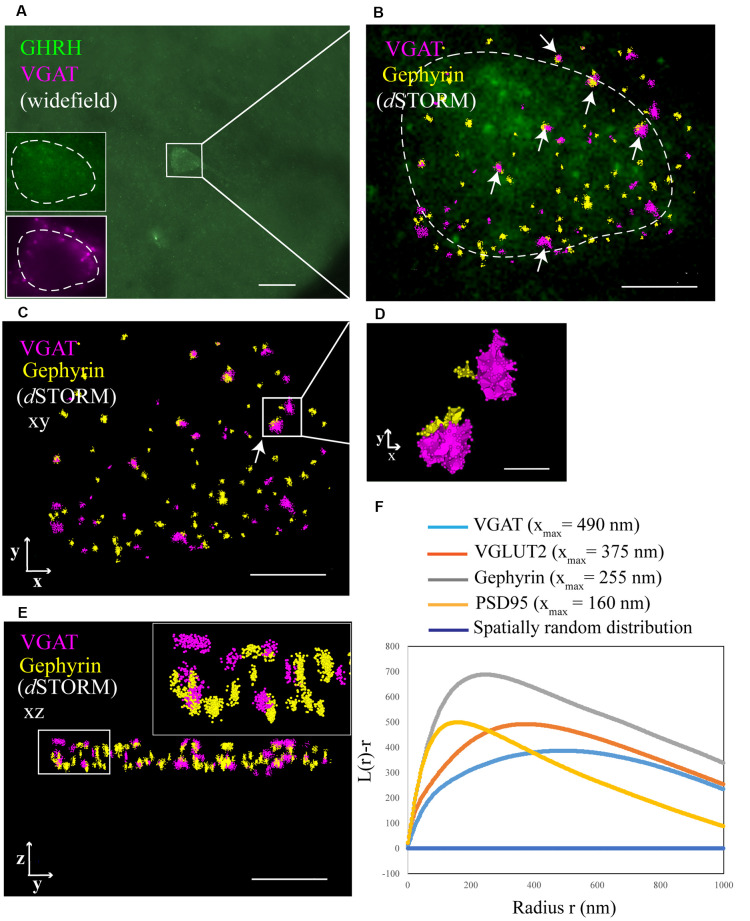
Identification of synaptic inputs to GHRH neurons with dSTORM. (A) An overview widefield image of a GHRH-positive neuron (AF488, green) in the arcuate nucleus of the hypothalamus and two widefield zoomed-in images of the same GHRH cell (left bottom corner, top insert) and of a pre-synaptic marker VGAT (AF647, magenta; bottom insert). (B) Enlarged view of the reference GHRH cell shown in panel (A), with inhibitory VGAT and Gephyrin (post-synaptic) clusters imaged using dSTORM and rendered with a Density-Based Spatial Clustering of Applications with Noise (DBSCAN) algorithm, displayed as pointcloud. Synaptic inputs to GHRH neurons are shown with arrows and identified as opposing pre- and post-synaptic clusters with an inter-cluster distance of <250 nm. (C) A pointcloud visualization of synaptic markers from panel (B) without the reference GHRH cell in the background, shown in the XY-plane. (D) Enlarged clusters of VGAT and Gephyrin from panel (C) to highlight lateral resolution. (E) YZ-plane depiction of VGAT and Gephyrin. The axial resolution allows 3D distance analysis. Scale bars: (A) = 20 μm (B,C,E) = 4 μm, (D) = 500 nm. (F) A general cluster test by Ripley’s H analysis, represented as a normalized Ripley’s H function (L(r)-r) for indicated synaptic proteins. The peak indicates the highest degree of aggregation at specific interacting distance r compared to a spatially random distribution with L(r)-r of 0 (dark blue line). Pre-synaptic proteins VGAT and VGLUT2 cluster at higher radii (490 nm and 375 nm, respectively), as compared to post-synaptic proteins Gephyrin and PSD95 (255 nm and 160 nm, respectively).